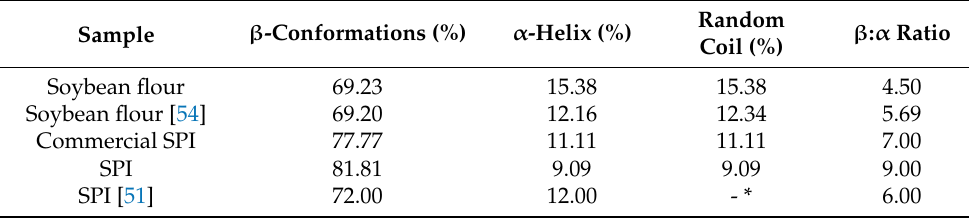
Table 7. Secondary structures determined by deconvolution of amide I, using ATR-FTIR. Sample